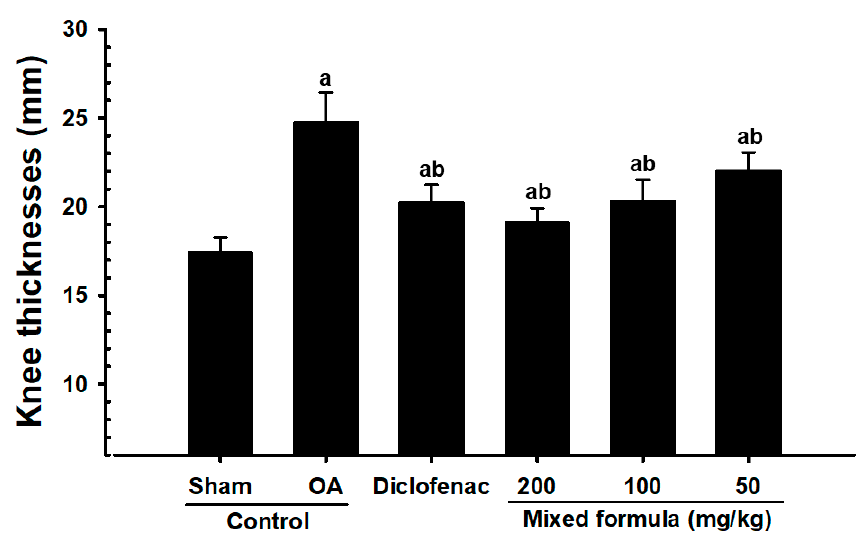
Figure 2. Knee thickness after capsule exposure in sham-operated or OA rabbits. Values are expressed as mean ± S.D. of eight rabbits, mm. OA = Osteoarthritis; AR = Aqueous extracts of Achyranthis Radix; EC = Aqueous extracts of Eucommiae Cortex; PCP = Dried Pomegranate Juice Concentrated Powder. a p < 0.01 as compared with sham control; b p < 0.01 as compared with OA control.